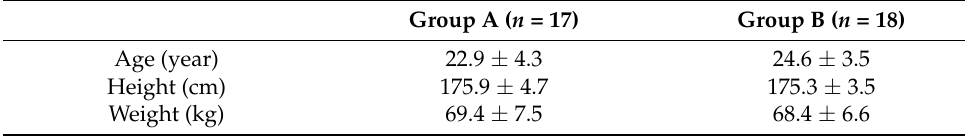
Table 1. Demographic characteristics of the subjects.